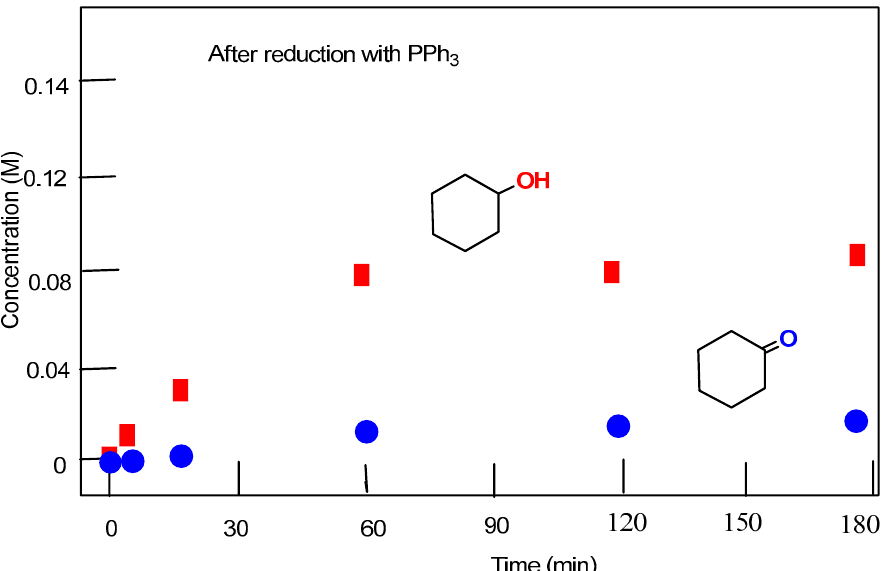
Figure 6. Accumulation of cyclohexanol and cyclohexanone in the oxidation of cyclohexane (0.46 M) with H 2 O 2 (2.0 M) catalyzed by complex 2 (5 × 10 − 4 M) in the absence of PCA, at 50 ◦ C in acetonitrile. Concentrations of products were measured by GC after the reduction of the reaction samples with solid PPh 3.